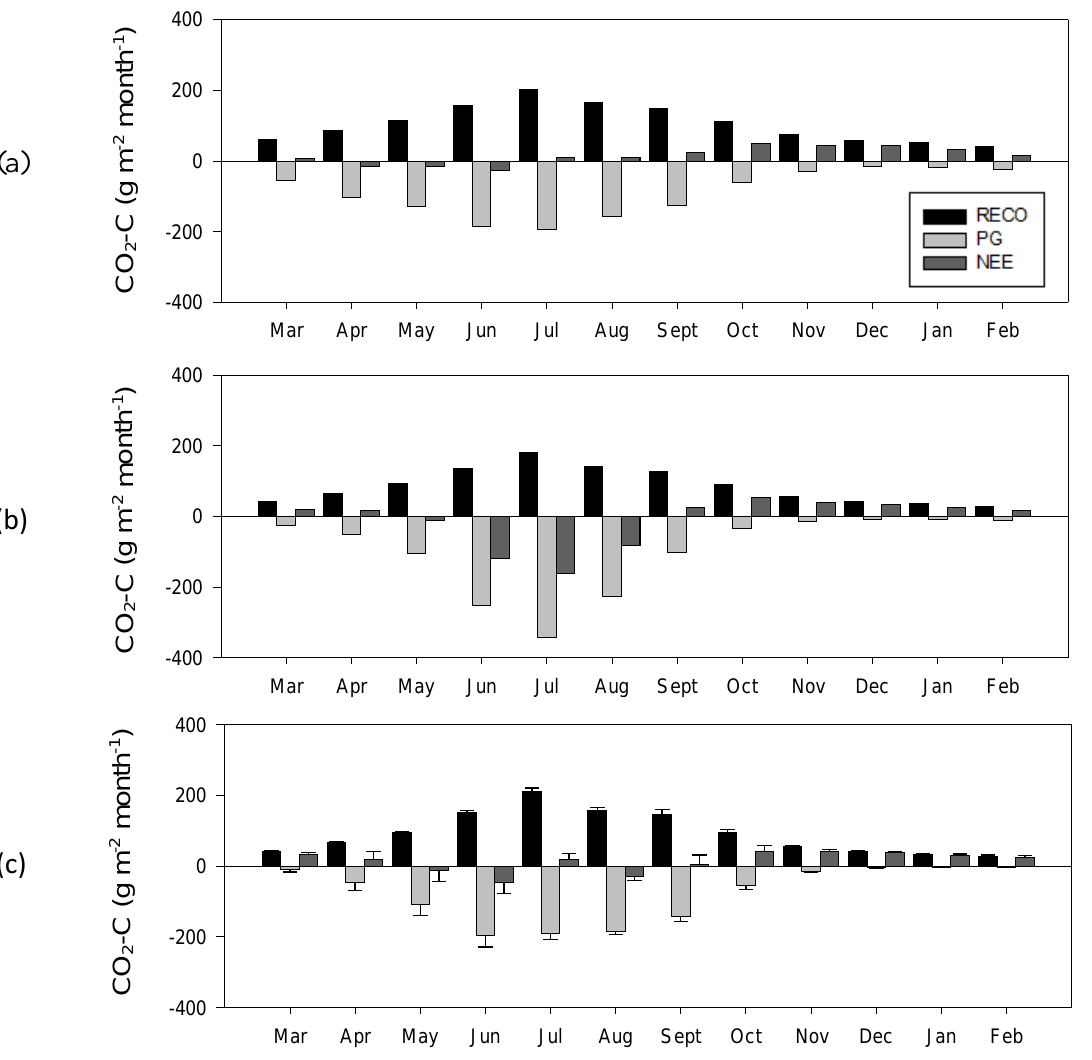
Figure 5. Average monthly modelled gross photosynthesis (P ), ecosystem respiration (R ) and net G eco ecosystem exchange (NEE) as CO -C (g m -2 month -2 ) for (a) Eriophorum - Sphagnum (b) Cladonia-Calluna , 2 and (c) Molinia caerulea sample plots at Pollagoona from March 2014 until February 2015. Positive values indicate losses of CO to the atmosphere while negative values indicate CO uptake by the peatland. Error 2 2 bars indicate standard errors for microsite types represented by more than one sampling